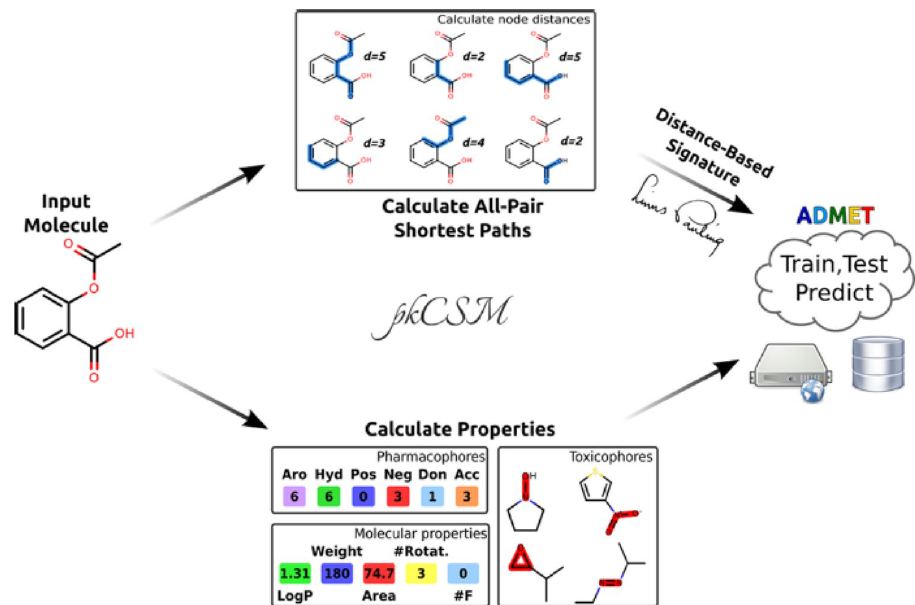
Fig. 6 The workflow of pkCSM is represented by the two main sources of informa- tion, namely, the calculated molecular properties and shortest paths, for an input molecule. With these pieces of information, the ML system is trained to predict ADMET properties. Reproduced with permission from the work of Pires et al.